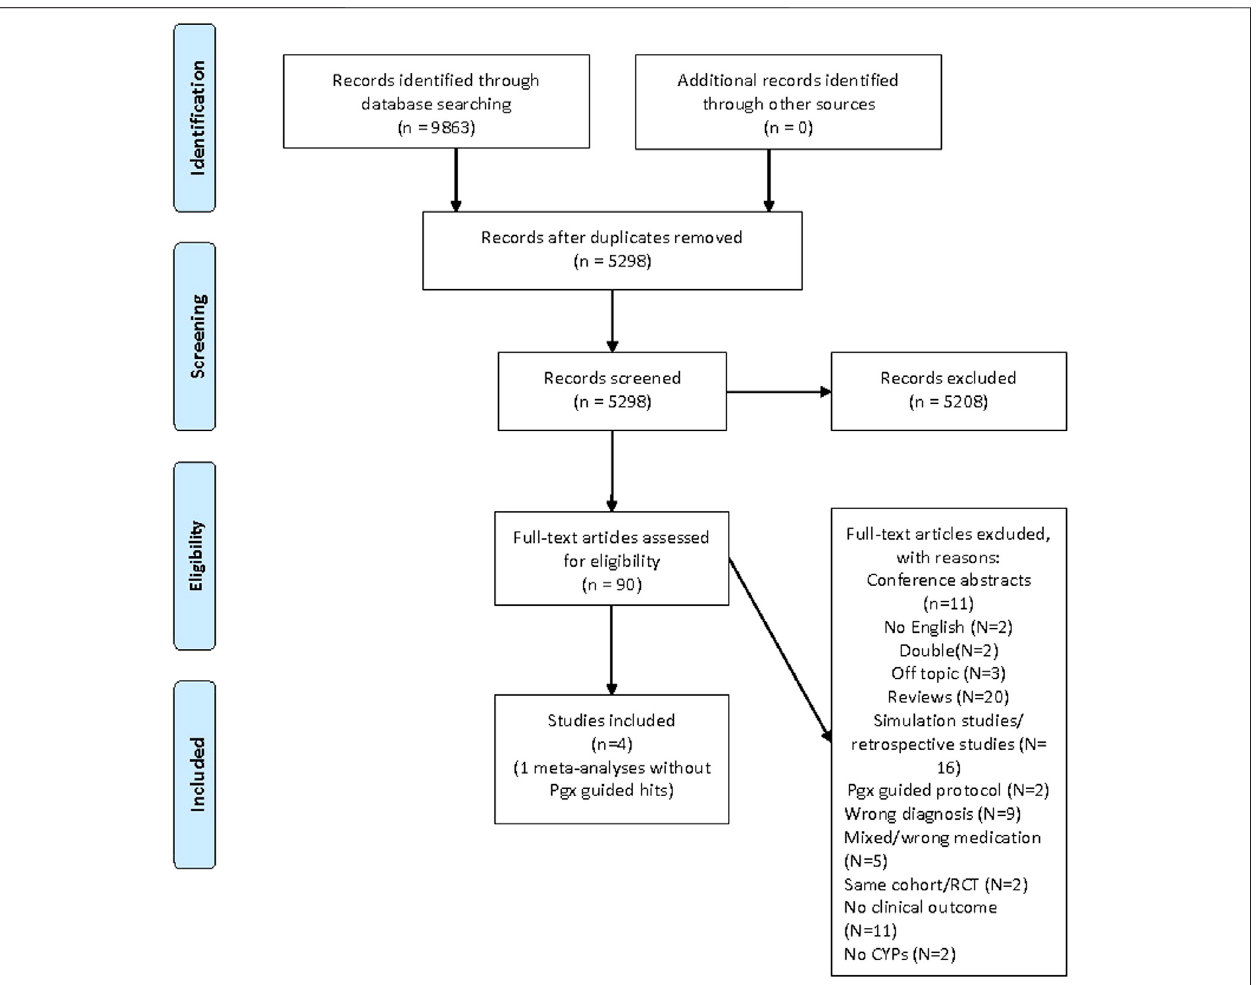
FIGURE 1 | PRISMA 2009 fl ow diagram- genotyping in